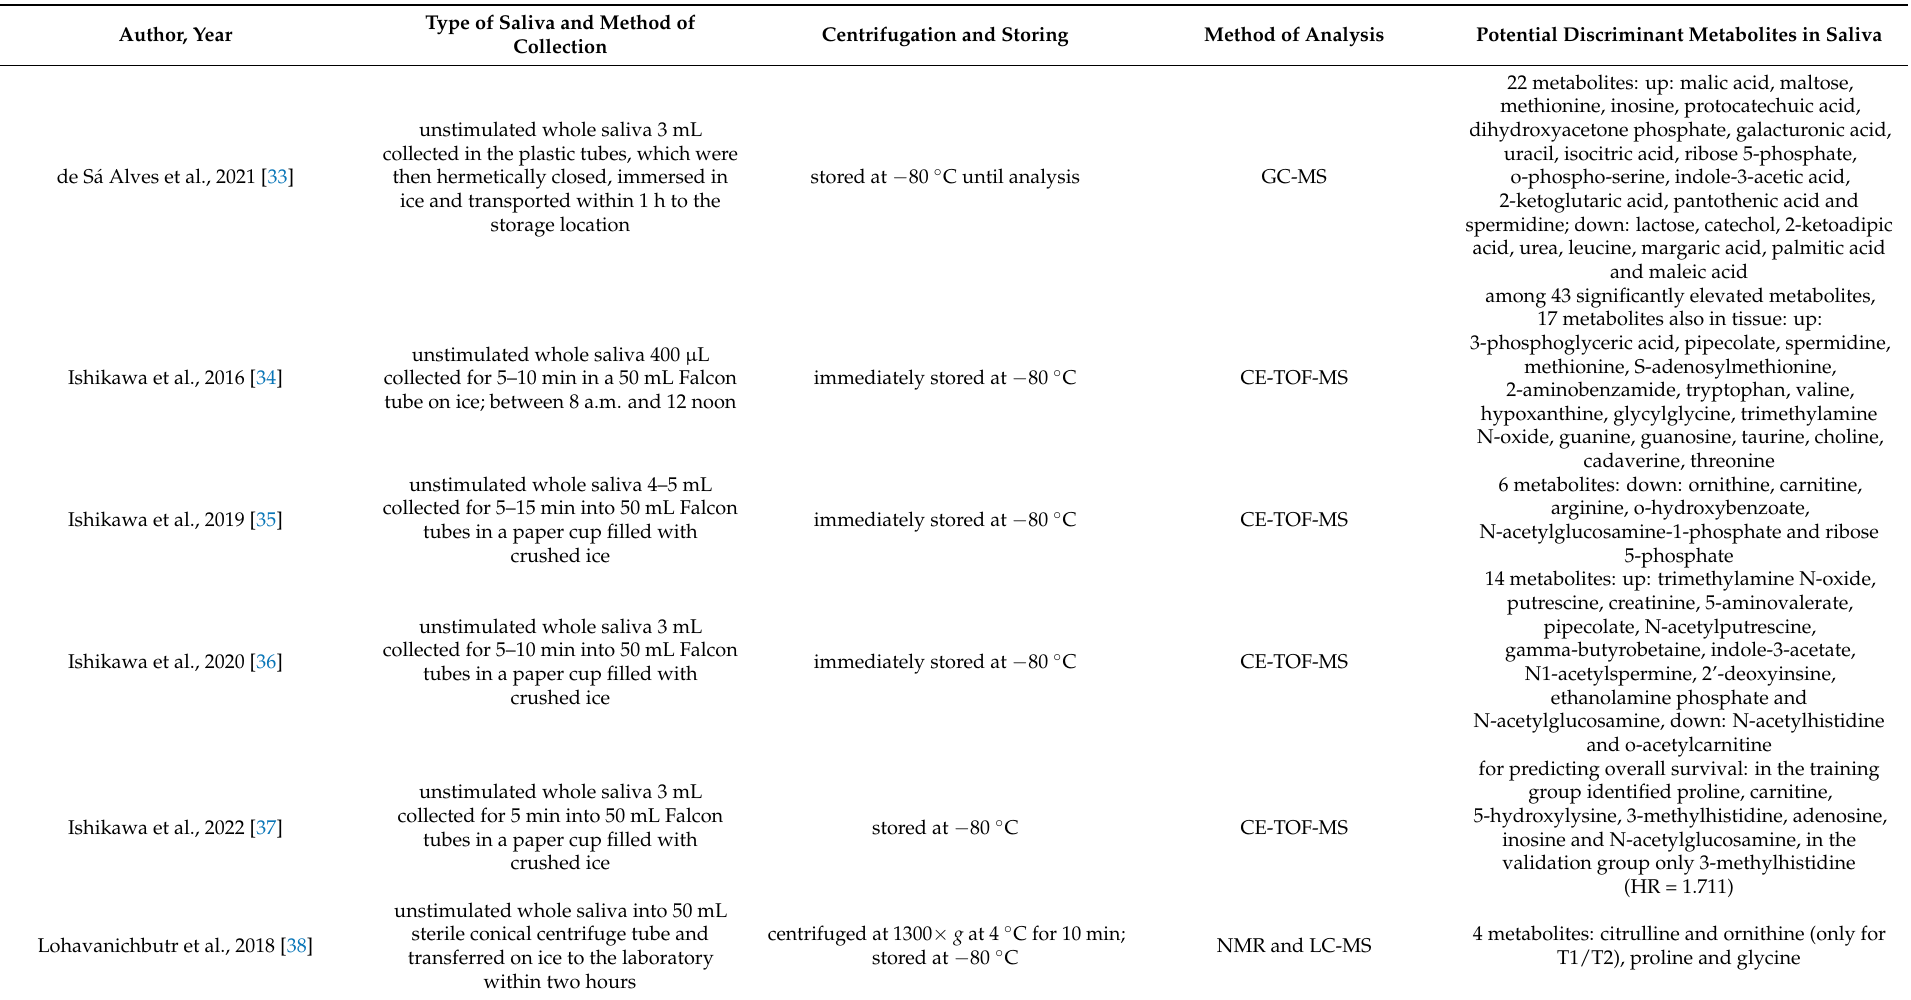
Table 2. Detailed characteristics of included studies considering methods of collection and analysis of